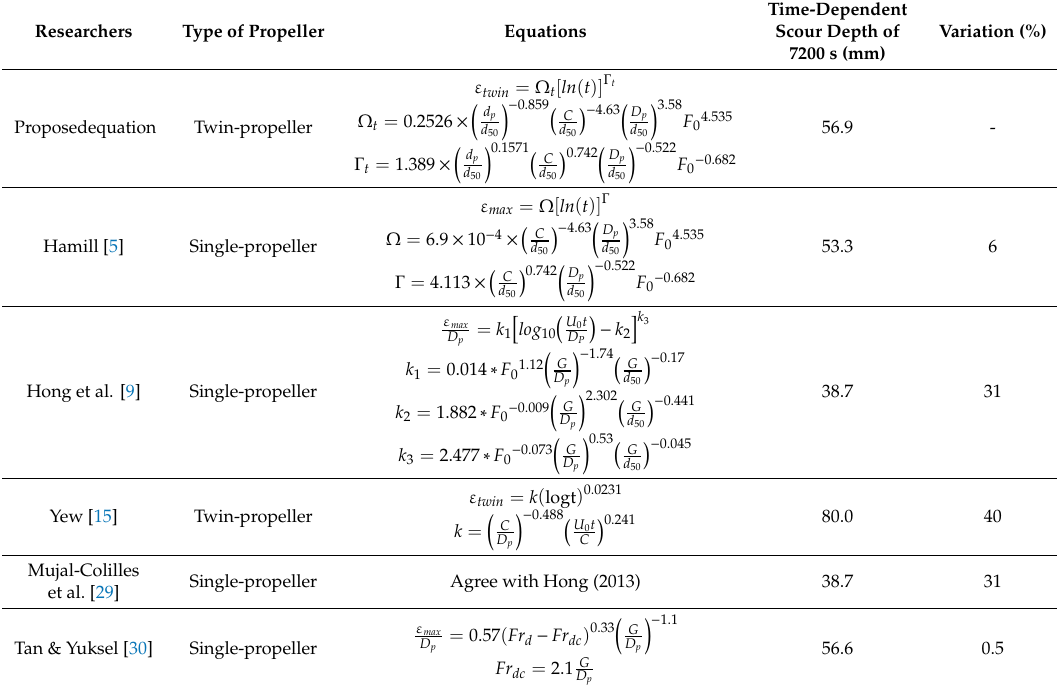
Table 6. Comparison of the proposed twin-propeller scour equation and previous researchers Researchers Type of Propeller Equations